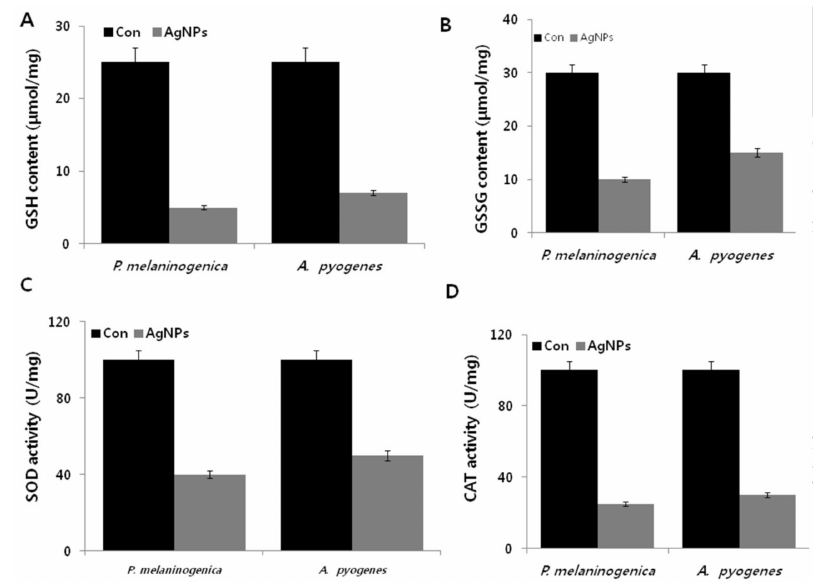
Figure 7. Effect of AgNPs on antioxidants. P. melaninogenica and A. pyogenes cells were treated with 0.8 and 1.0 µ g/mL of AgNPs respectively for 12 h, and the ( A ) GSH levels, ( B ) GSSG levels, ( C ) superoxide dismutase (SOD) activity, and ( D ) catalase (CAT) activity were measured as described in the Materials and